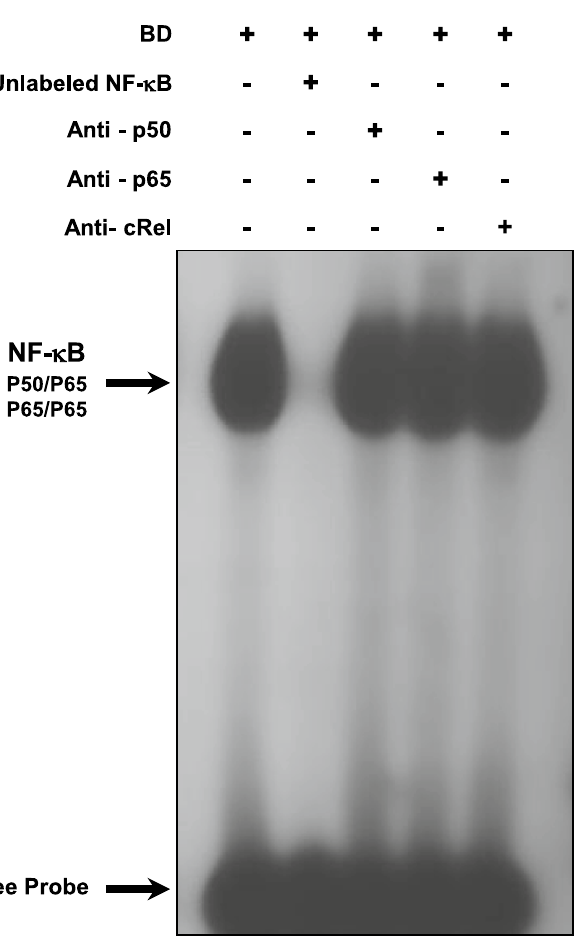
Figure 6. EMSA competition studies and supershift assays performed using nuclear extracts from hepatic tissue samples in the presence of specific oligonucleotides. Supershift assays were performed on nuclear extracts incubated in the absence and presence of antibodies against the p65, p50 and cRel subunits. The position of the specific NF-κB-binding complex (p50/p65) is indicated. The results are representative of three experiments. The raw pictures of the EMSA supershift assay are shown in Supplementary Fig. S2.